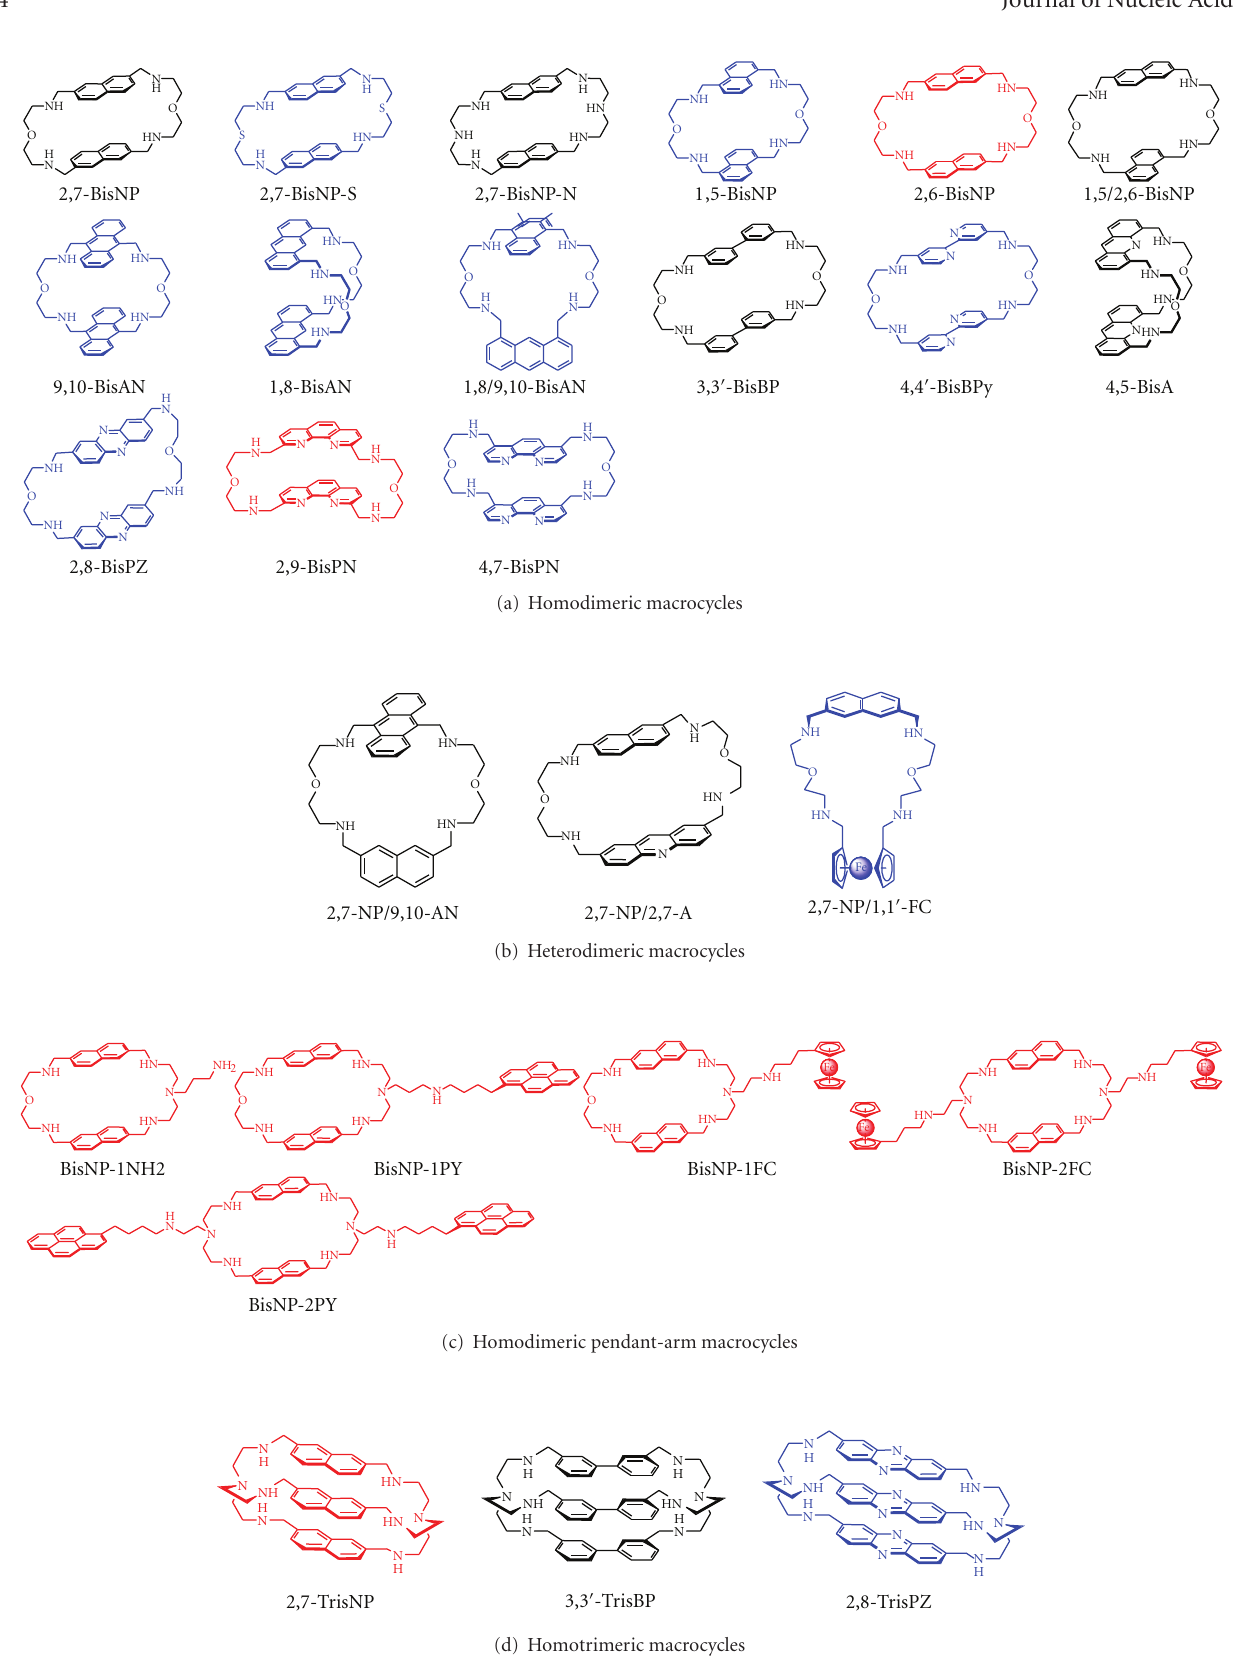
Figure 3: Structures of the 26 studied CBIs; see text below for the explanations of the color codes related to a ffi nity and selectivity of the